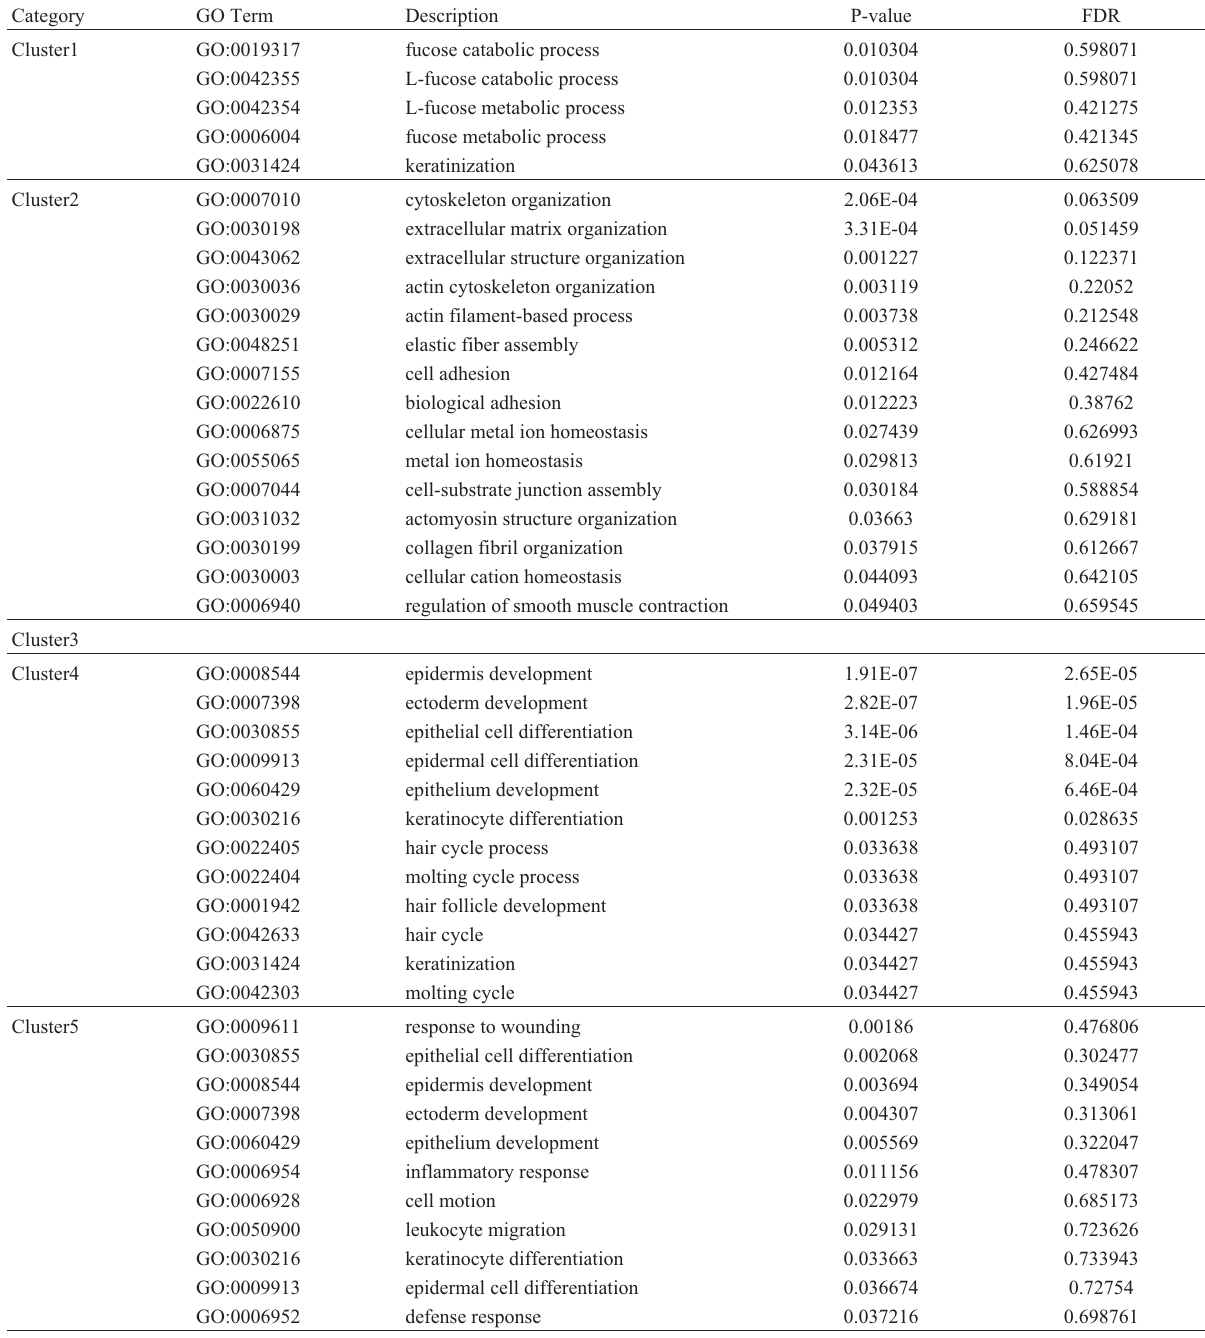
Table 1 - List of enriched GO terms in clusters 1 to 6 detected by